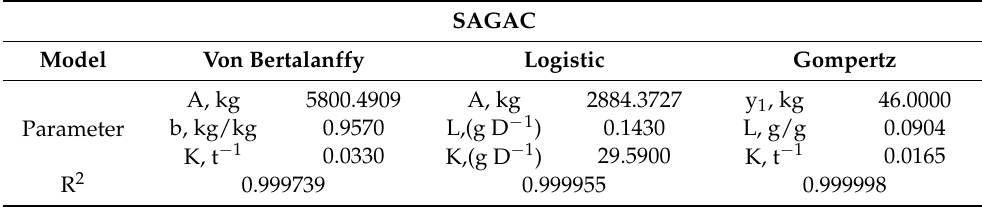
Table 6. Comparison of the obtained results for the three tested models for the broilers.